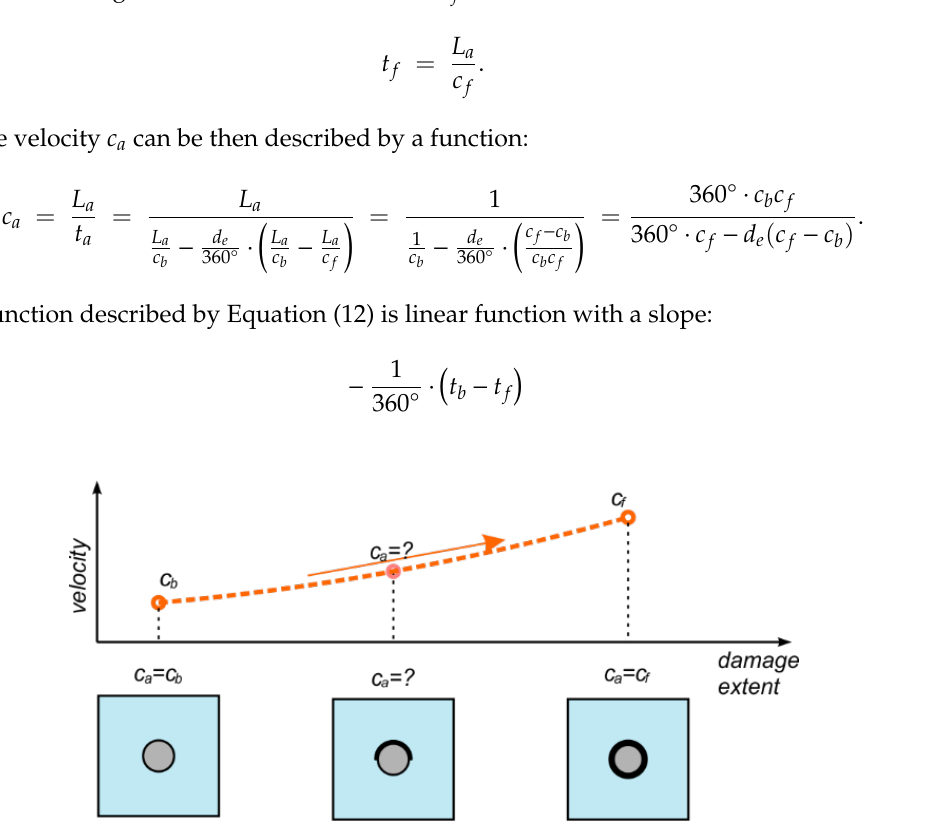
Figure 8. Initial part of the signal registered for the beam #D: determining the time of flight for overlapping wave packets.